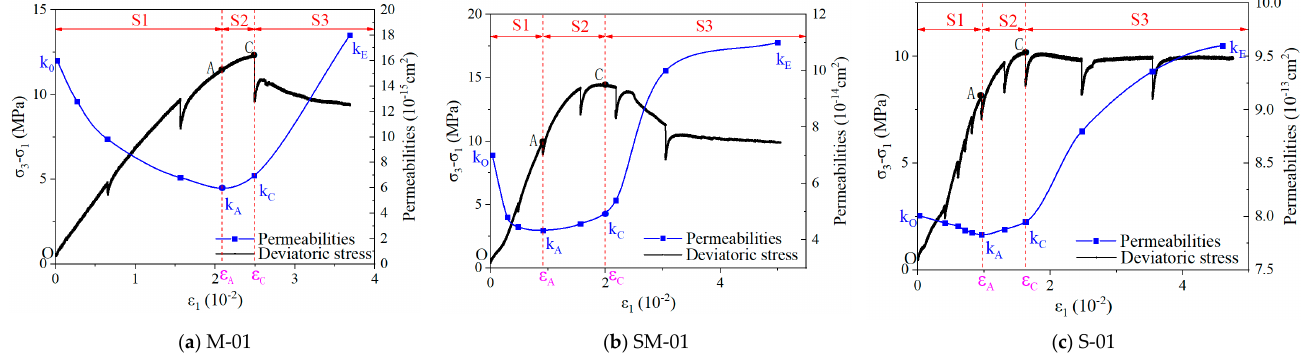
Figure 3. Stress-strain permeability relation curve under constant confining pressure. ( a ) mudstone; ( b ) sandy mudstone; ( c ) Sandstone.